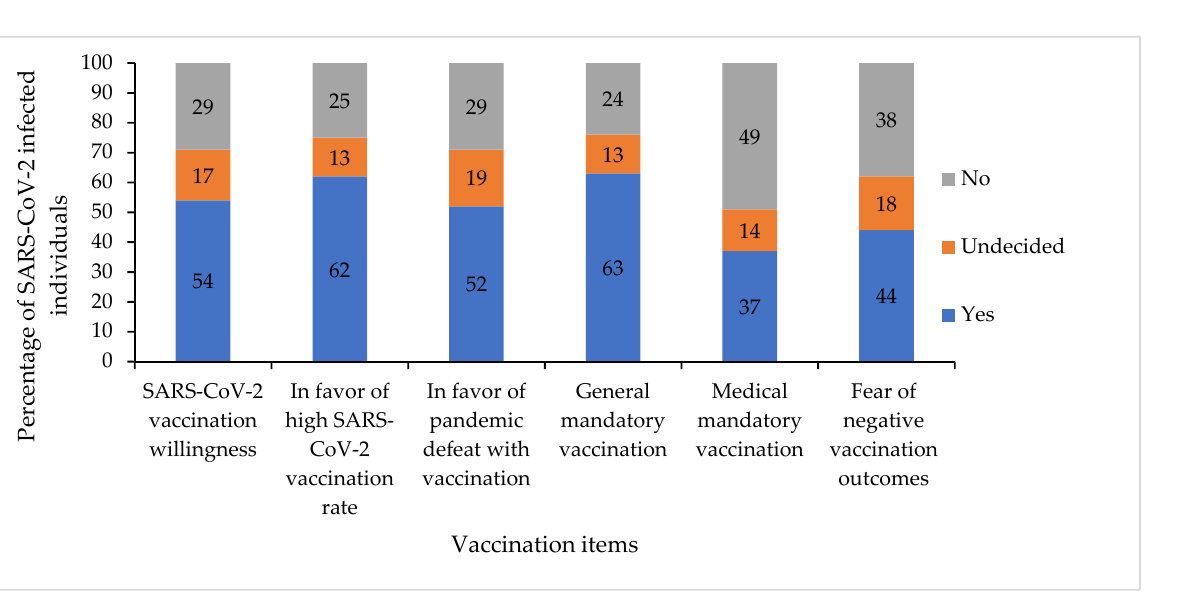
Figure 1. Vaccination attitudes of SARS-CoV-2 infected individuals ( n = 224). 3.3. Vaccination Attitudes Affecting Willingness to Receive Booster Vaccination The willingness of SARS-CoV-2 infected persons to receive a booster vaccination sig- nificantly and with strong effects correlated with other pro-vaccination items (Table 3). The pro-vaccination items and the mandatory vaccination items were positively related